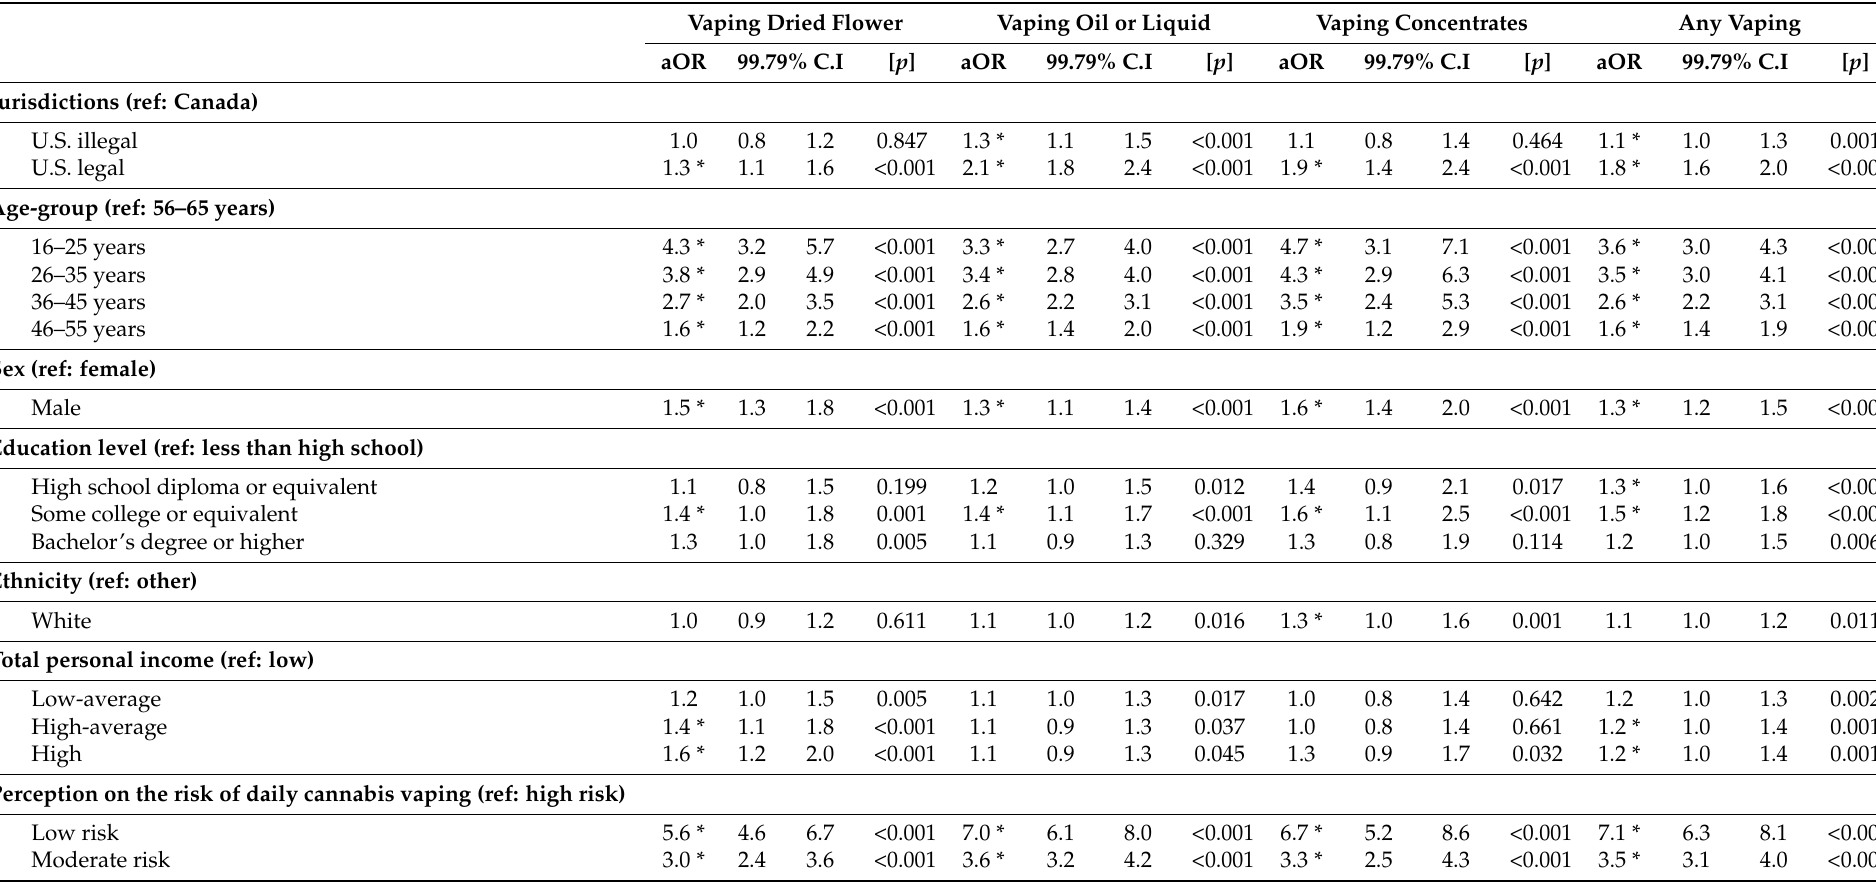
Table 2. Socio-demographics correlates and risk perception of vaping dried flower, oil or liquid, and concentrates in the past year, all jurisdictions a . Vaping Dried Flower Vaping Oil or Liquid Vaping Concentrates Any